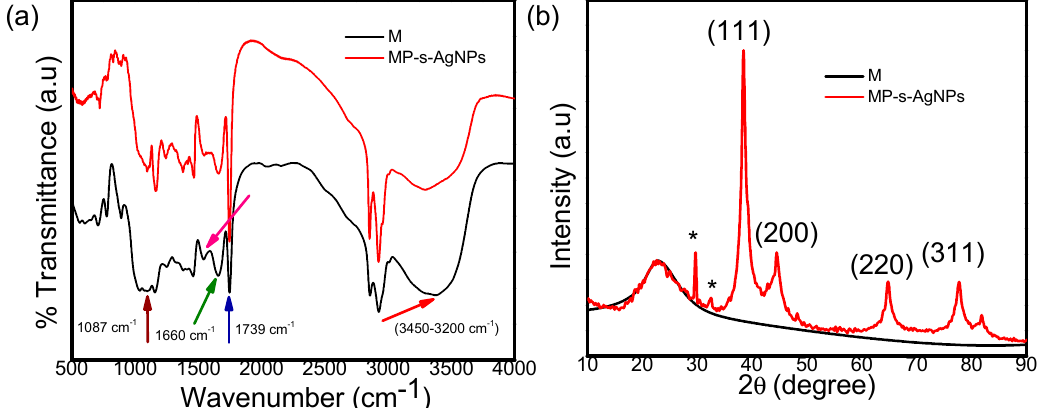
Figure 3. ( a ) FTIR spectra of commercial milk (M) and MP-s-AgNPs and ( b ) shows the X-ray diffraction pattern of commercial milk and MP-s-AgNPs.